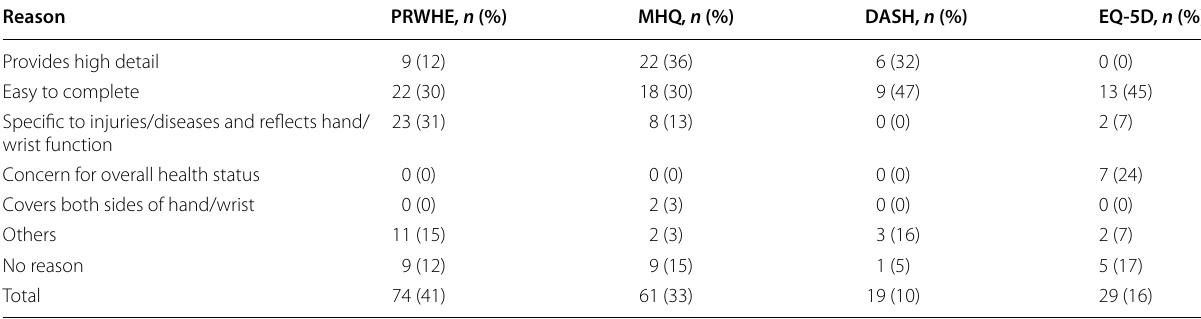
Table 2 Patients’ PROM preferences and reasons for those preferences ( n